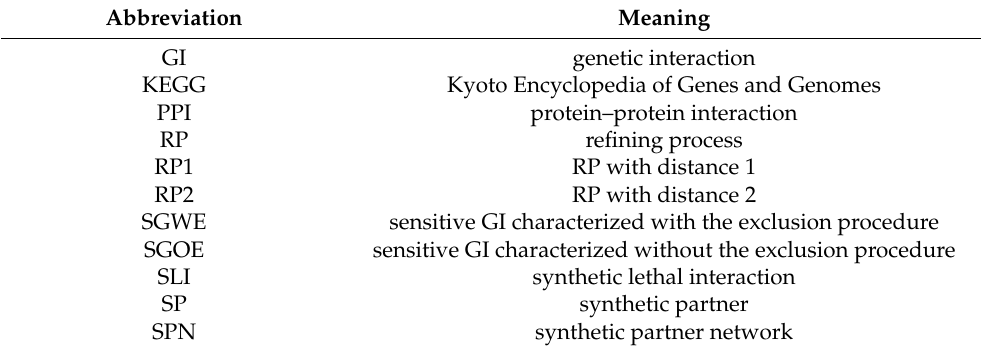
Table 1. The used